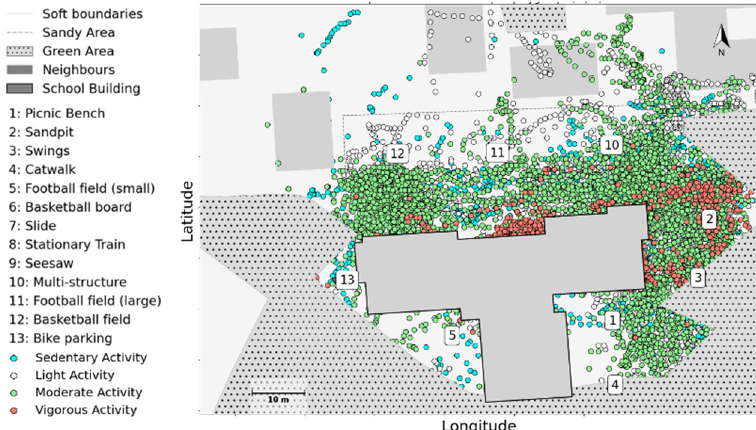
Figure 6. The location of physical activity levels in school B was analysed via Accelerometer data and then fused with GPS locations.